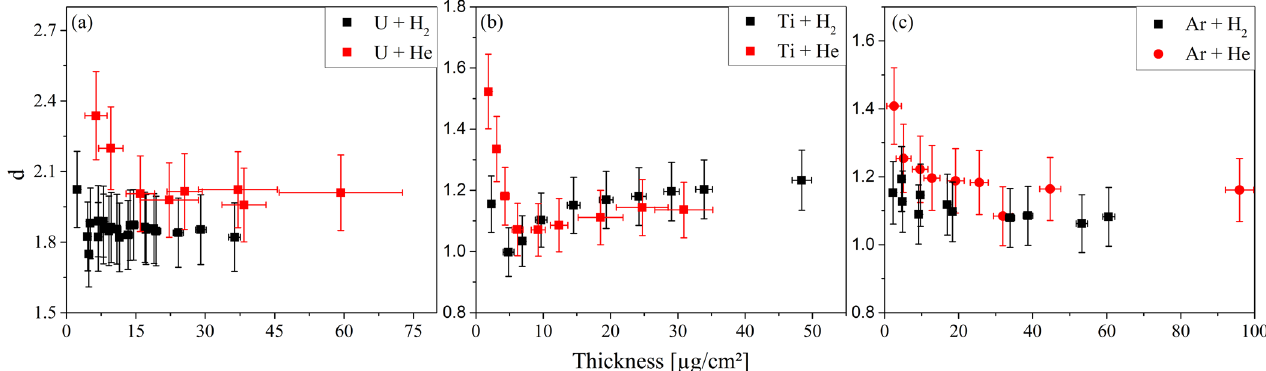
FIG. 12. Width d of the charge state distributions of 238 U (a), 50 Ti (b), and 40 Ar (c) ion beams on H 2 and He gas at 1 . 4 MeV =